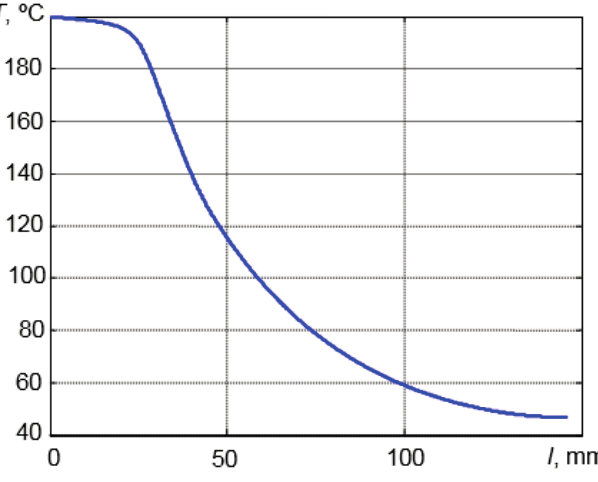
Figure 5. Temperature distribution along the center line of the waveguide.